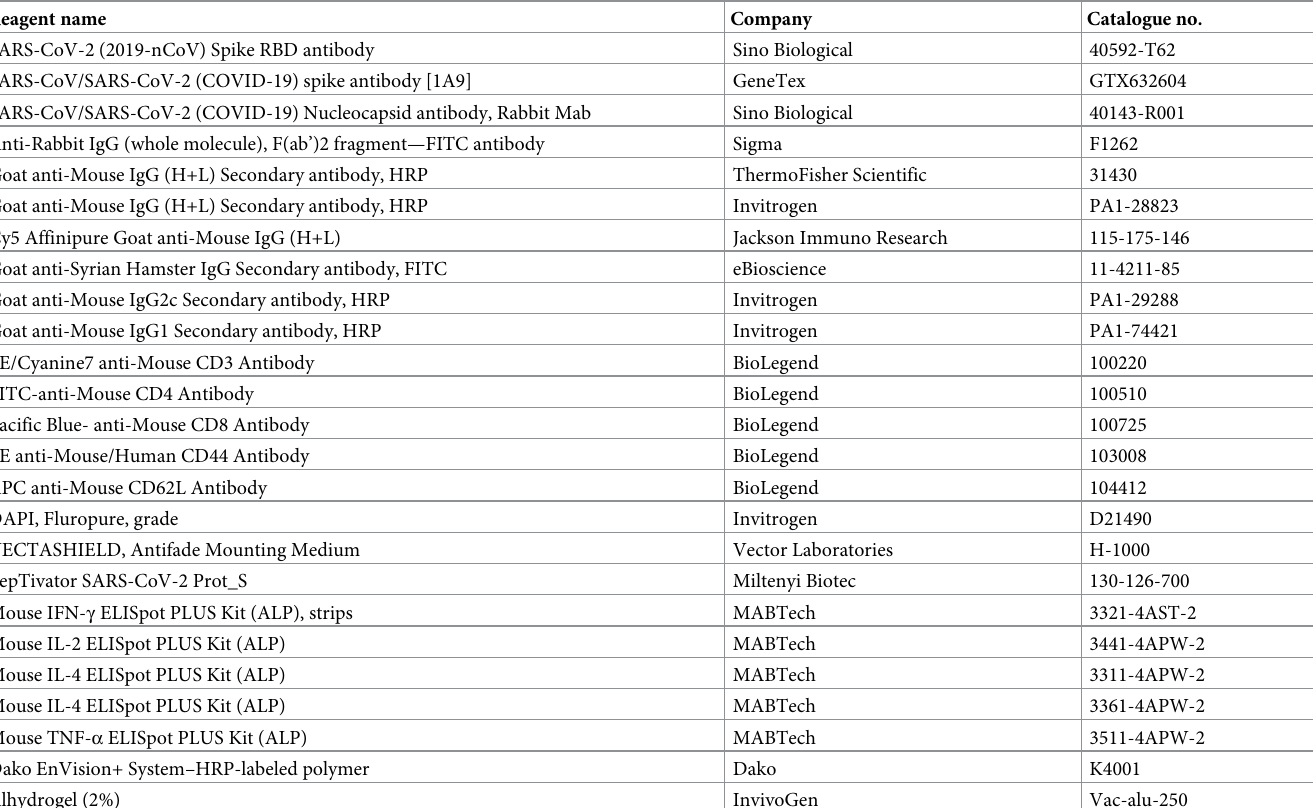
Table 1. Reagent